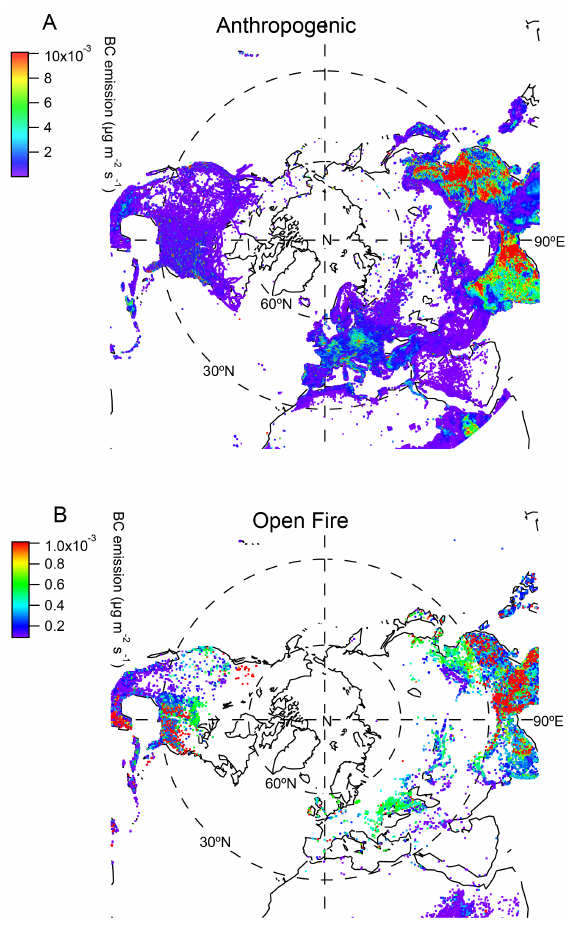
Figure 6. The BC anthropogenic (a) in March 2010 and open fire (b) emission inventories in March 2013, from HTAPv2 and the FINN open fire biomass burning inventory respectively. The speci- fied sectors for anthropogenic sources, i.e. residential activity, trans- port, industry, energy and flaring are shown in Fig. S3.